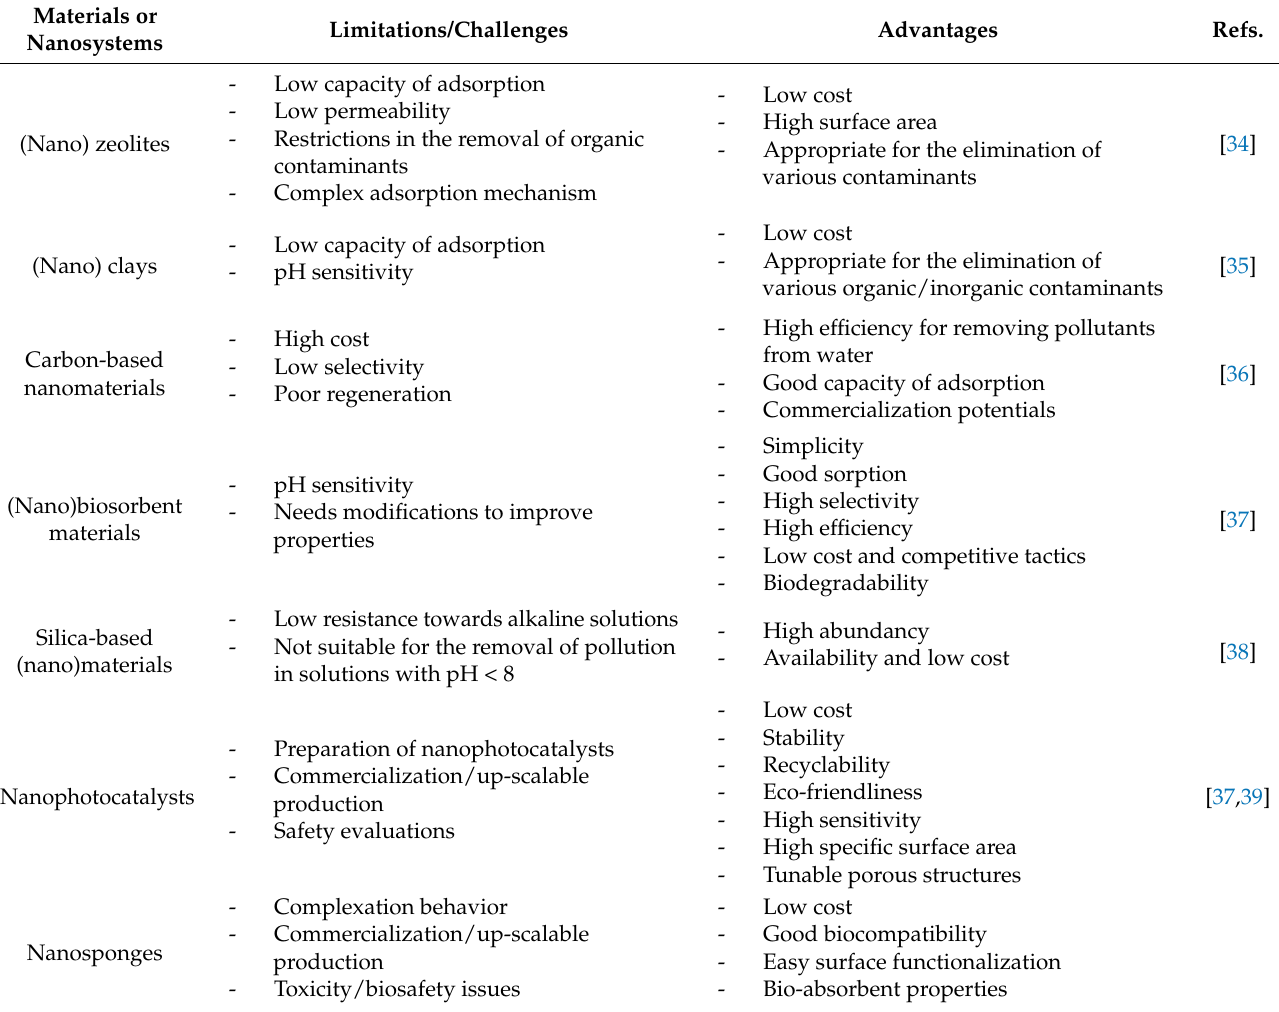
Table 2. Some salient advantages and limitations of materials/nanosystems applied for water treatment and pollutant removal from aqueous